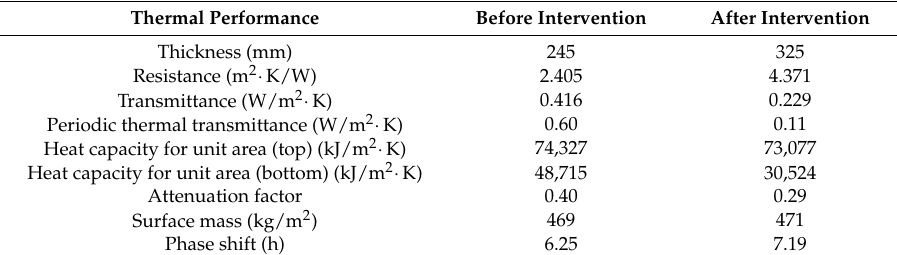
Table 4. Villa Sciarra ceiling thermal performance before and after intervention.